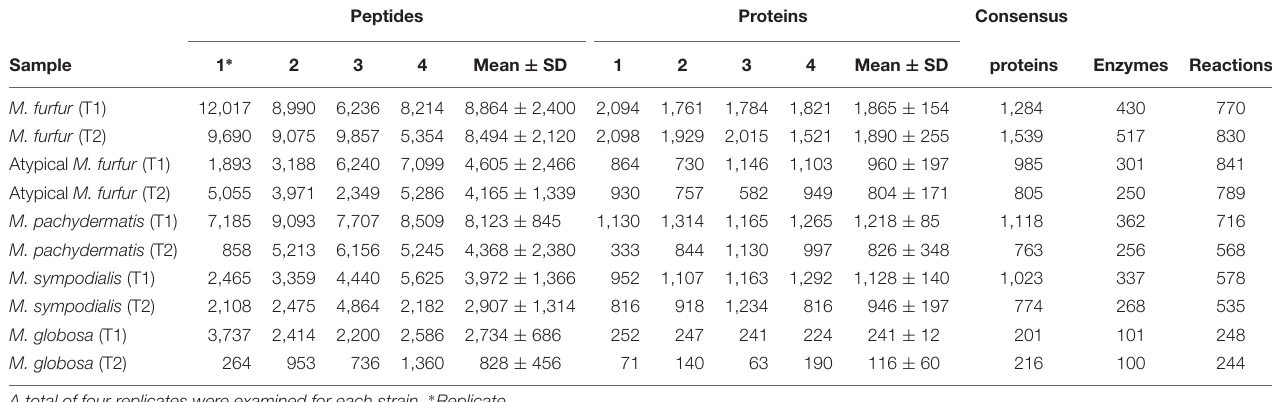
TABLE 5 | Proteomic profiling results of five strains of Malassezia during the exponential (T1) and stationary (T2) phase. Peptides Proteins Consensus